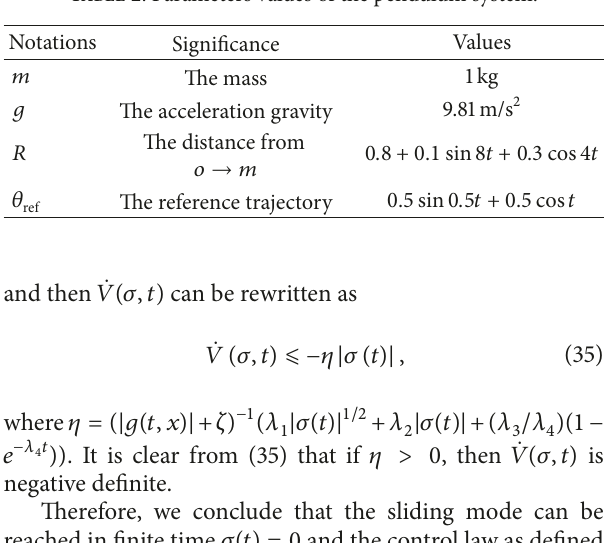
Table 2: Parameters values of the pendulum